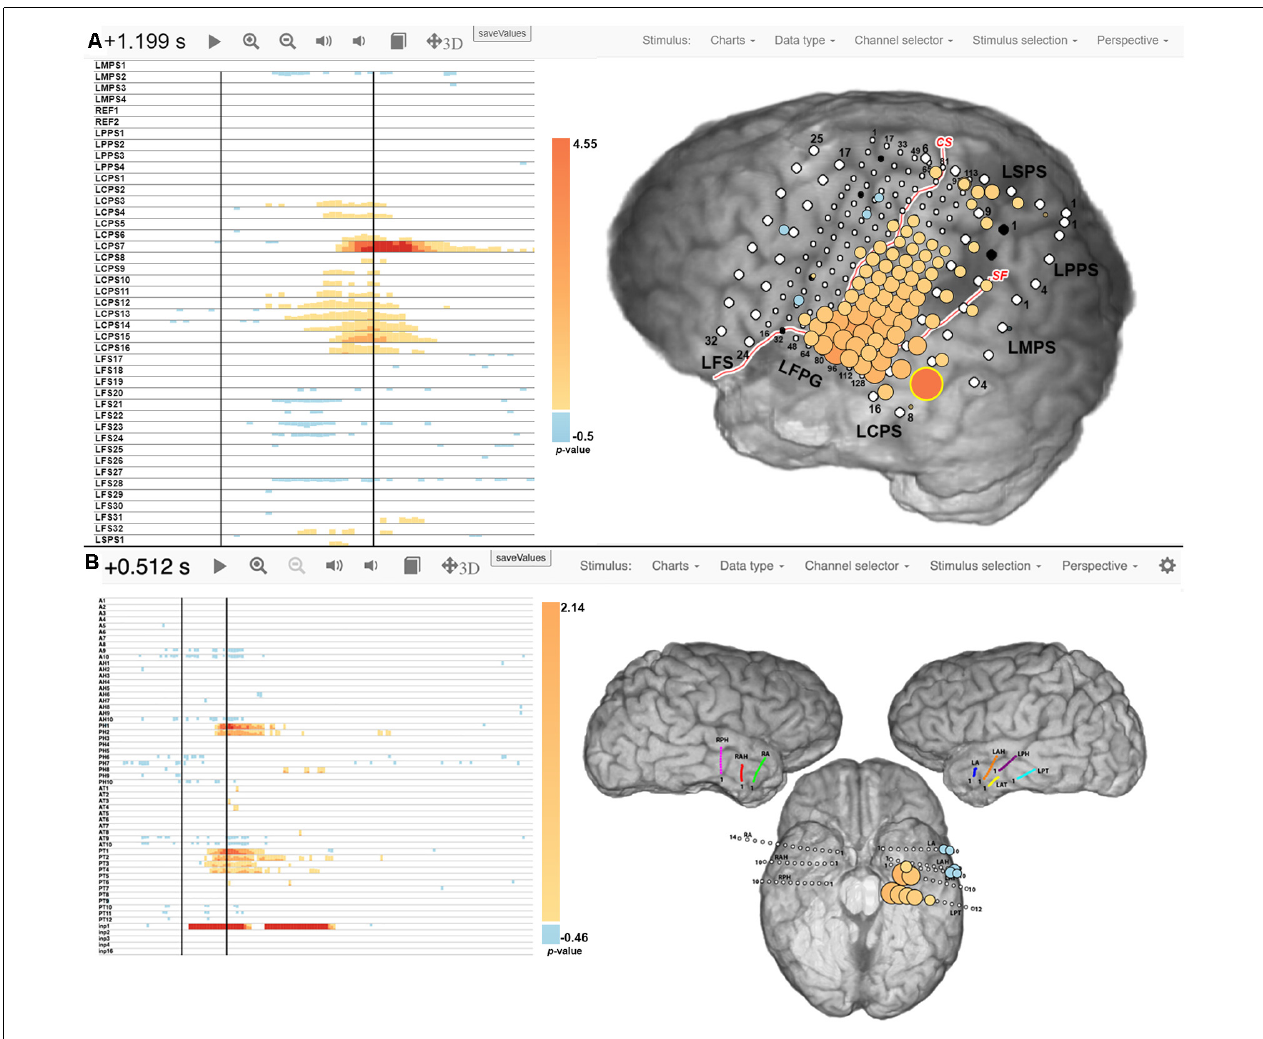
FIGURE 2 | Spatial-temporal functional mapping (STFM) results for Patient 2 during a word reading task (A) and Patient 5 during a picture naming task (B) . The raster plot on the left shows trial-averaged STFM results in a time by channels manner, and the brain map on the right shows STFM results on an anatomical illustration at a specific time stamp. More details can be found at Wang et al. (2016) and Milsap et al. (2019).